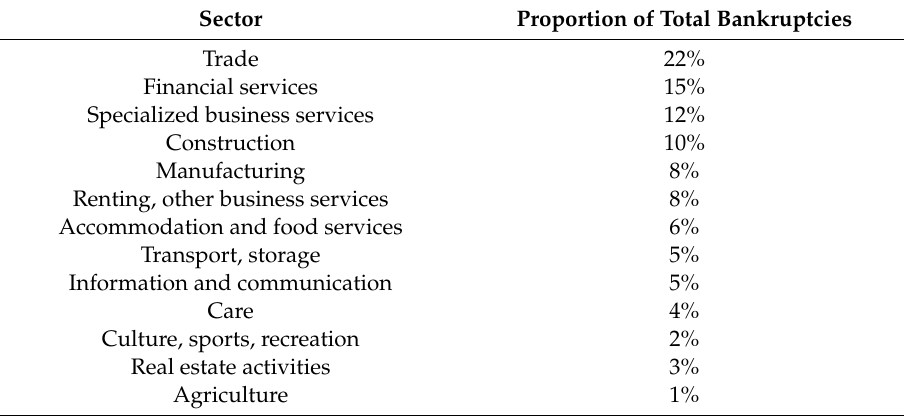
Table 2. Bankruptcies of businesses and institutions in the Netherlands in 2017 by sector. Sector Proportion of Total Bankruptcies Trade